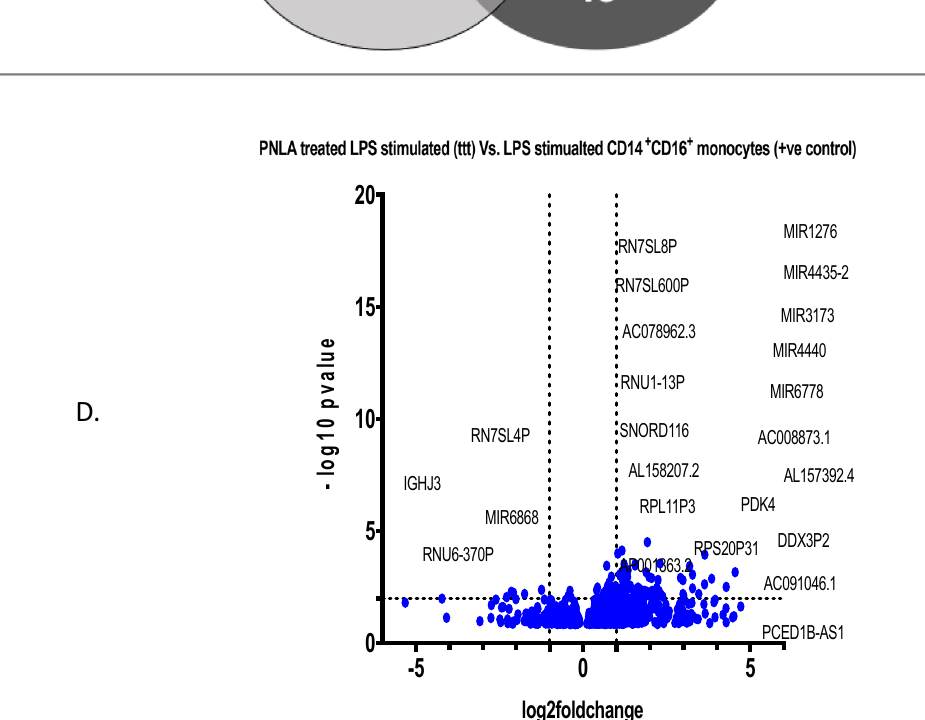
Figure 4. Venn diagrams showing the significantly affected miRNAs; ( A ) unstimulated (vehicle) vs LPS- stimulated monocytes ( B ) PNLA-treated LPS-stimulated vs vehicle-treated LPS-stimulated monocytes, ( C ) PNLA-treated LPS-stimulated vs unstimulated (vehicle-treated) monocytes (p value < 0.05), and ( D ) Volcano plots of global significant and non-significant genes of protein coding and non-coding DEGs of PNLA treated/ LPS stimulated versus LPS stimulated